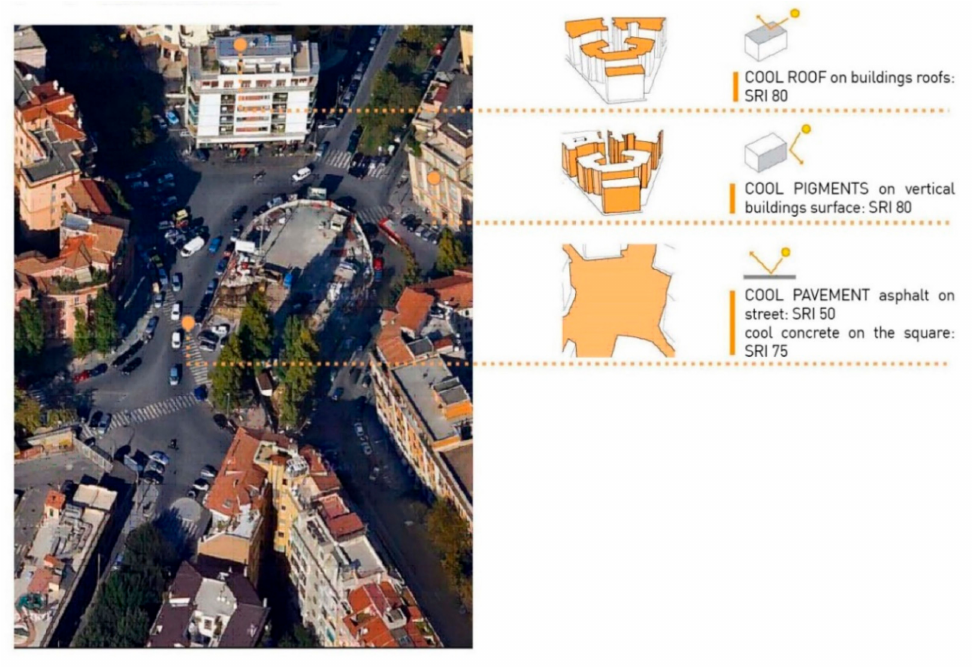
Figure 6. Scenario of intervention 1: surface renovation.